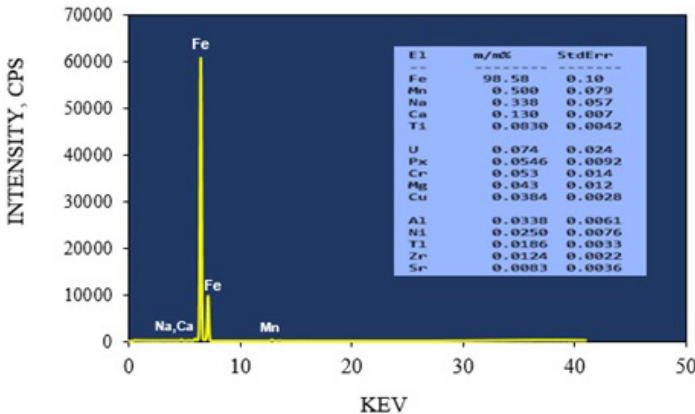
Figure 11. The X-Ray spectrum analysis of the elemental composition of the iron powder produced after reduction at 1000 o C.